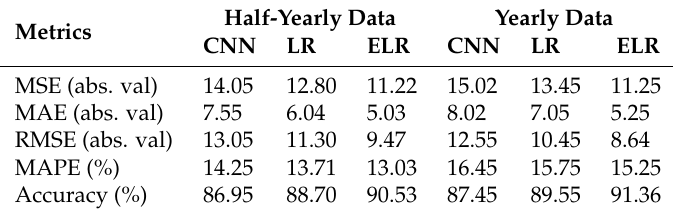
Table 17. Price performance metrics comparison for one week using the UMass Electric Dataset.